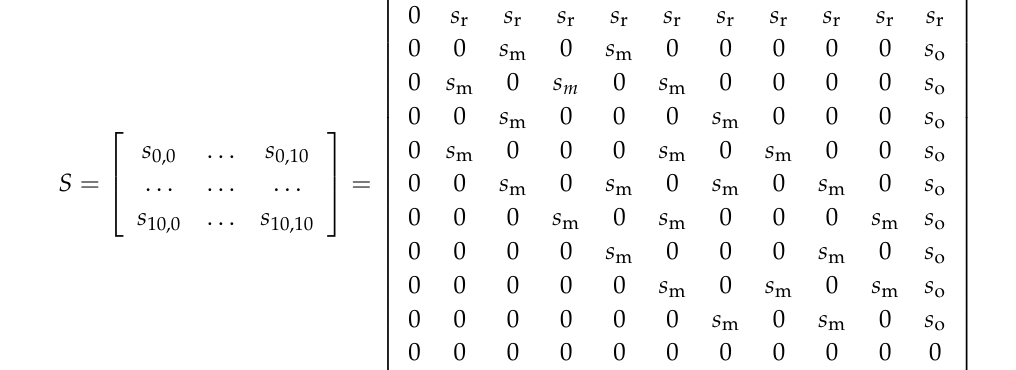
connected by horizontal and vertical lines. So, the central oscillator No.5 has four couplings in the matrix, the corner oscillators have two couplings, and the oscillators in the center of the edges have three couplings (with the central oscillator and two corner ones) and they all unidirectionally affect oscillator No.10 (output neuron) in the output layer ( s i,10 = s o and s 10,i = 0, where i = 1 . . . 9). Importantly, there is the reference oscillator No.0 in the circuit and the synchronization order of all other oscillators is measured against this oscillator. Oscillator No.0 (Figure 2) unidirectionally affects all other oscillators ( s 0,i = s r , and s i,0 = 0, where i = 1 . . .